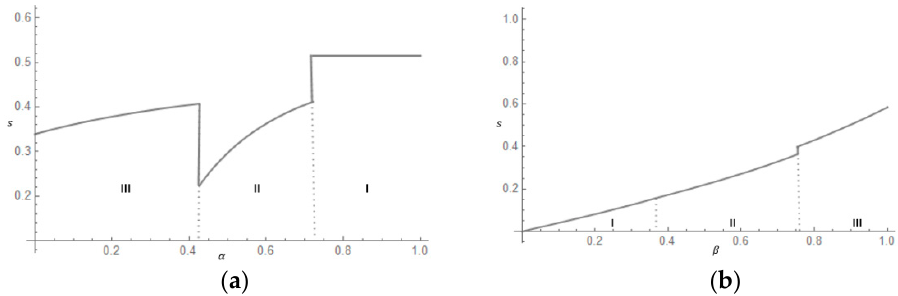
Figure 6. The influence of α and β on service level: ( a ) the influence of α on service level; and ( b ) the influence of β on service level.